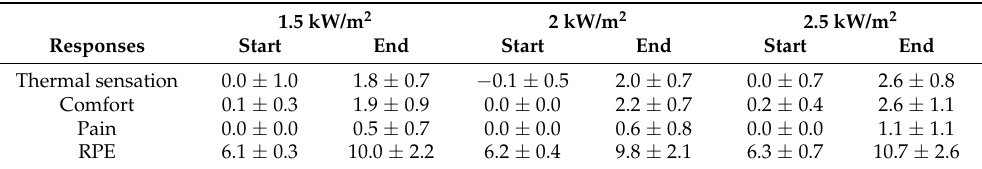
Table 5. Subjective responses at the start and at the end of each exposure to various radiation intensities (mean ± SD).